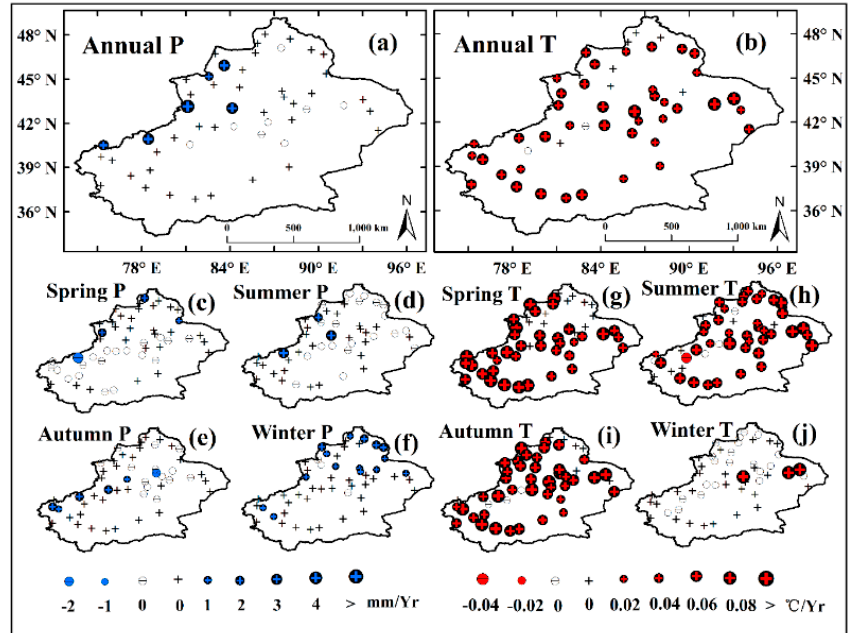
Figure 4. Spatial distribution of trends in precipitation ( left ) and temperature ( right ). ( a ) annual precipitation (annual P); ( b ) annual temperature (annual T); ( c ) spring precipitation (spring P); ( d ) summer precipitation (summer P); ( e ) autumn precipitation (autumn P); ( f ) winter precipitation (winter P); ( g ) spring temperature (spring T); ( h ) summer temperature (summer T); ( i ) autumn temperature (autumn T); and ( j ) winter temperature (winter T) based on 51 meteorological stations from 1982 to 2011. Larger circles indicate stronger increasing/decreasing trends.